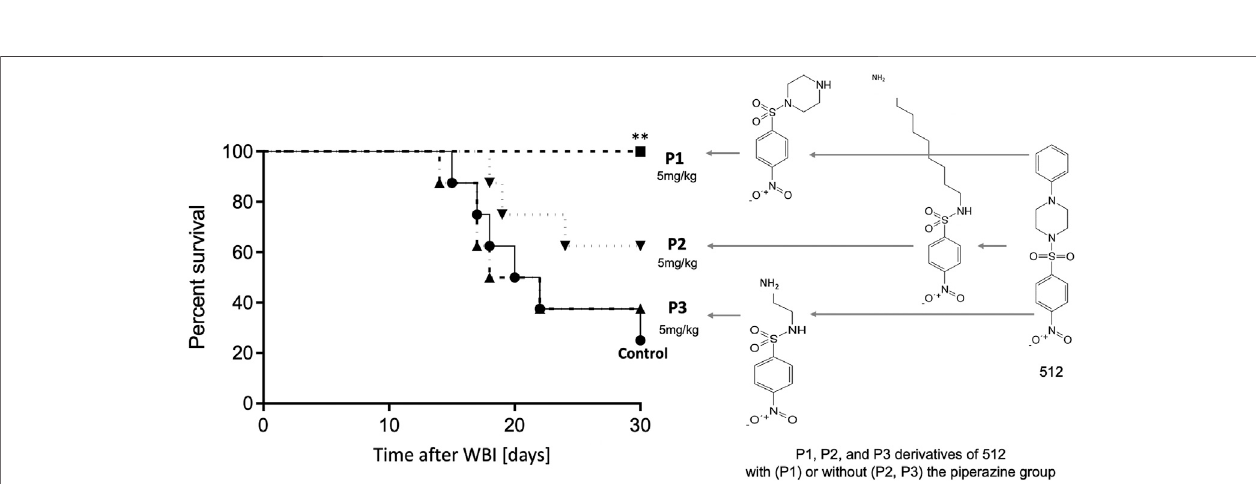
Frontiers in Pharmacology |